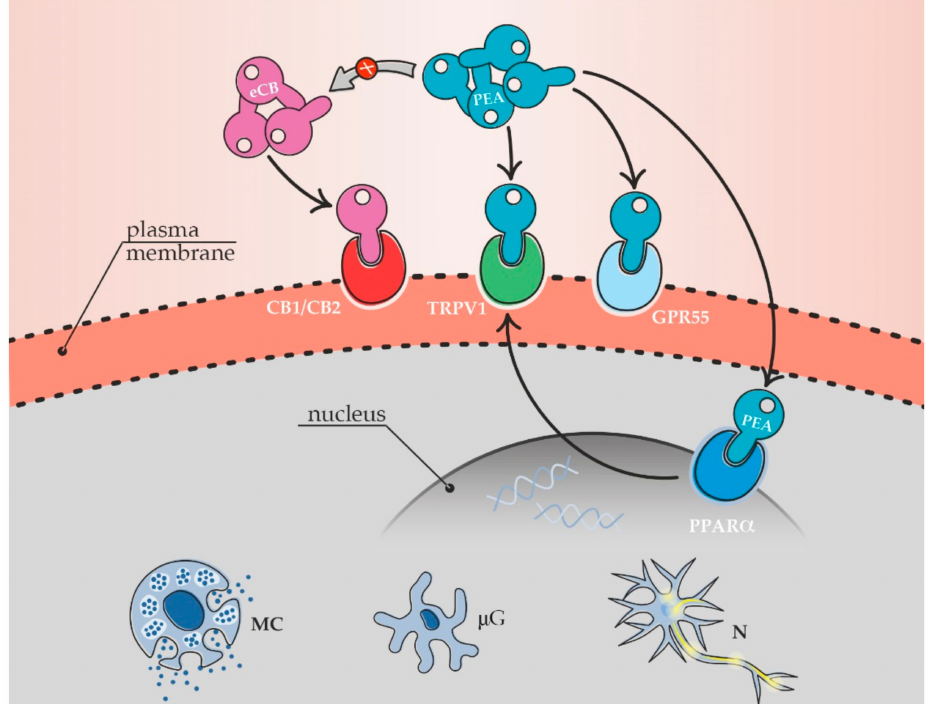
Figure 3. Direct and indirect agonism of PEA (blu key) on canonical (CB1, CB2) and putative (TRPV1, GPR55, PPAR α ) cannabinoid receptors expressed on the plasma membrane and/or nucleus of neuronal and non-neuronal cells. The multitarget receptor mechanism allows for the physiological control of pain pathways by PEA. (eCB, endocannabinoids, e.g., anandamide, AEA and 2-arachydonoylglycerol, 2-AG; MC, mast cell; µ G, microglia; N,